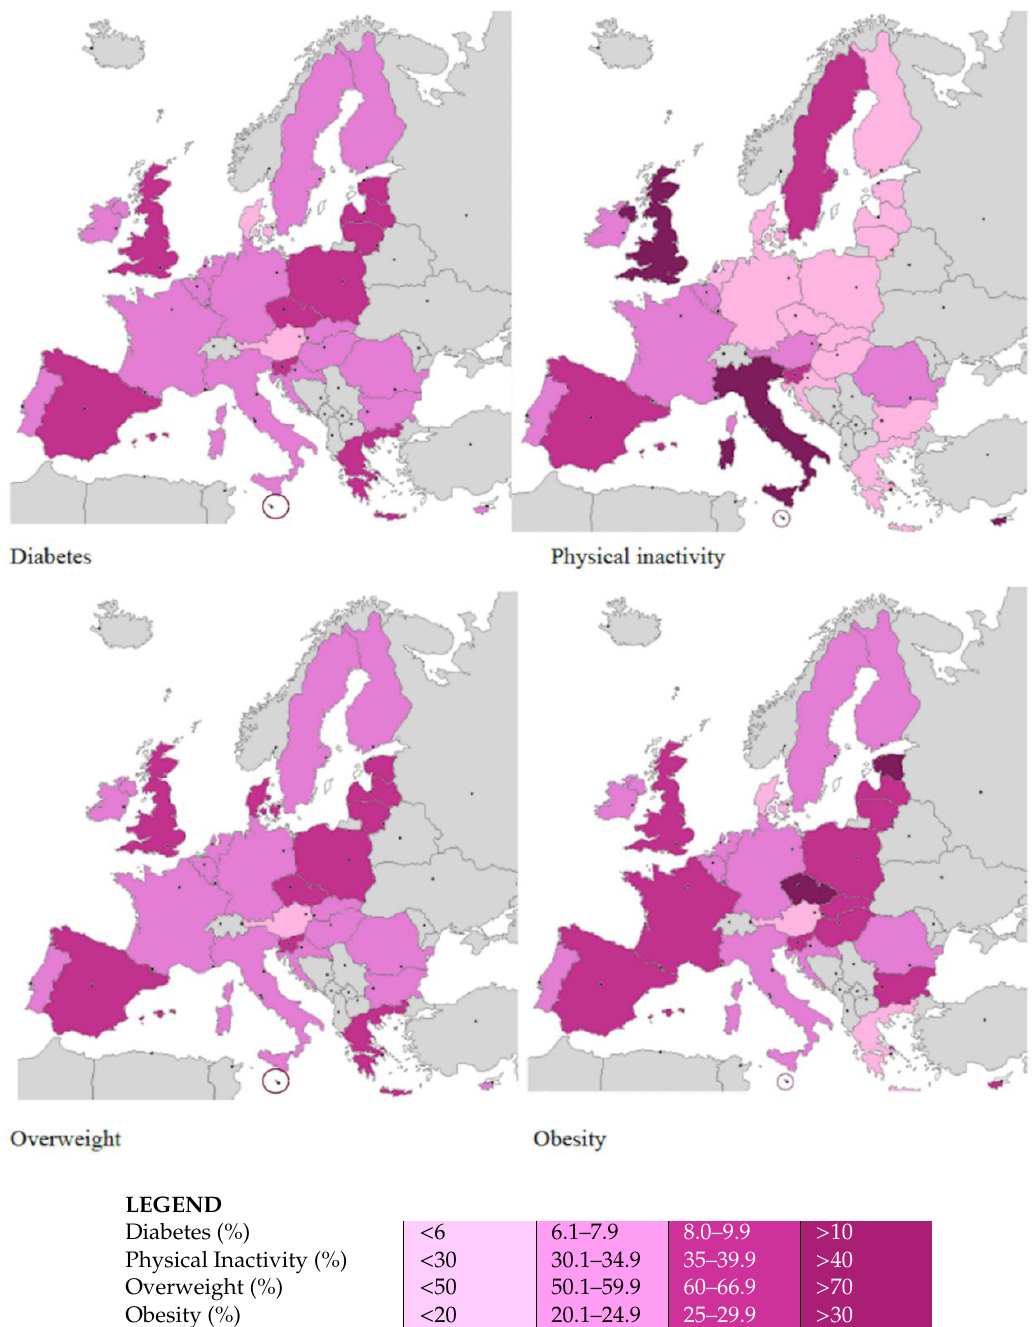
Figure 2. Type 2 diabetes and risk factors in females.